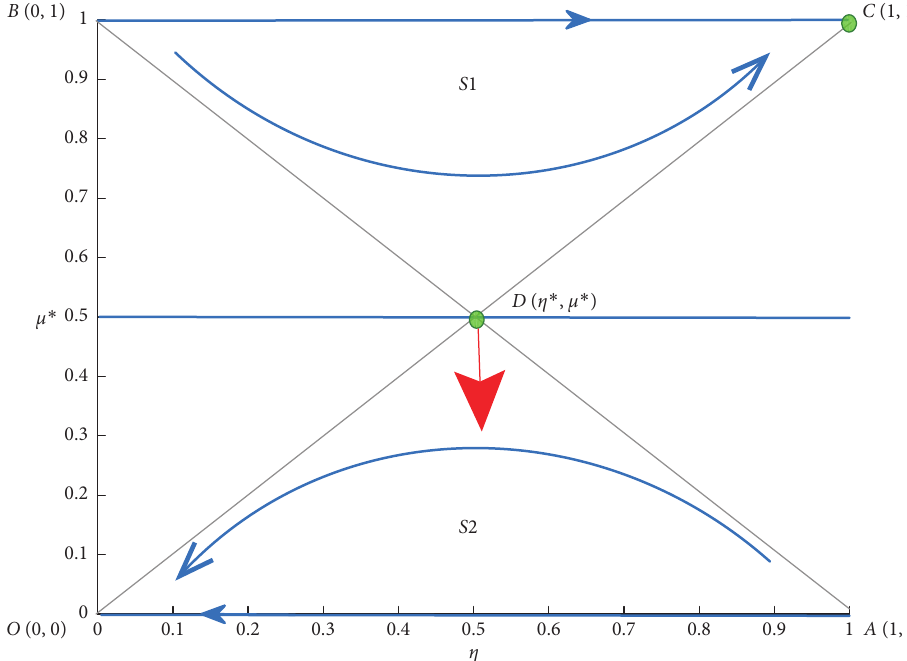
Figure 10: The evolution state of the system.